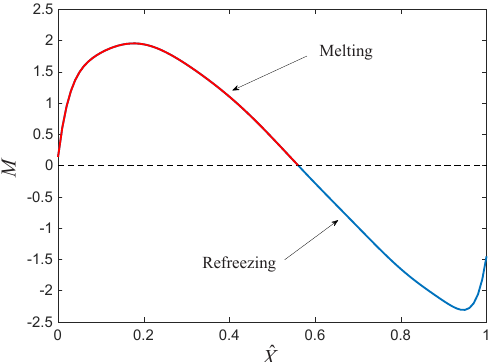
Figure 2. Dimensionless melt curve ˆ M( ˆ X) used in the basal melt parametrization. Higher melt rates typically occur close to the grounding line with a maximum at ˆ X ≈ 0.2. A transition from melt- ing (red) to refreezing (blue) may occur further away from the grounding line, depending on the position of the ice front. Note that the value of ˆ X depends on the distance to the grounding line, as well as the temperature difference T a − T f and the local slope α (see Ap- pendix A). In other words, ˆ X = 0 corresponds to the grounding line, but the dimensionless position of the ice-shelf front depends on the length scale and is not necessarily equal to ˆ X = 1.